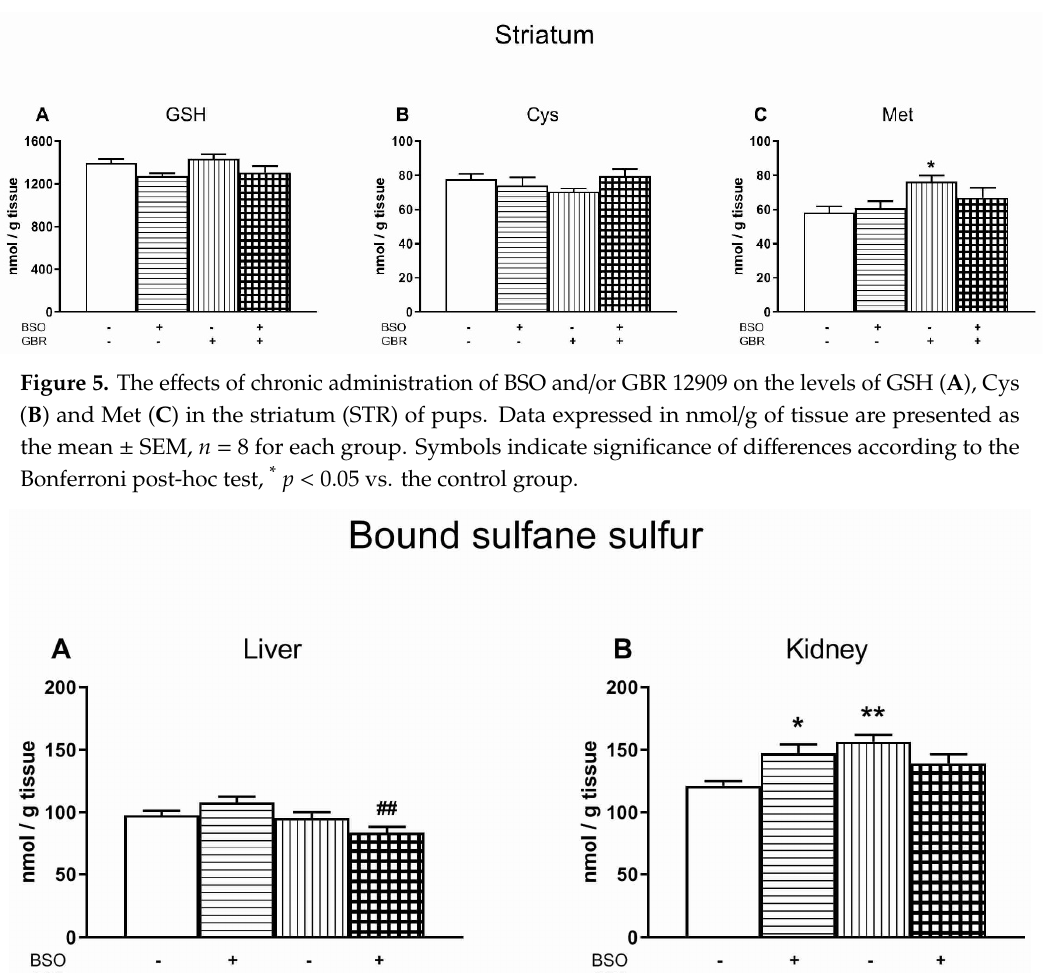
Table 2. The effects of chronic treatment with BSO and/or GBR 12909 on the levels of glutathione (GSH), cysteine (Cys) and methionine (Met) in the peripheral organs and selected brain structures of 16-day-old Sprague-Dawley rats according to Górny et al. [34].